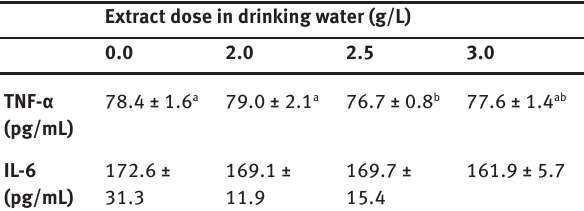
Table 3: Inflammatory markers in overweight Wistar rats after 42-day treatment.